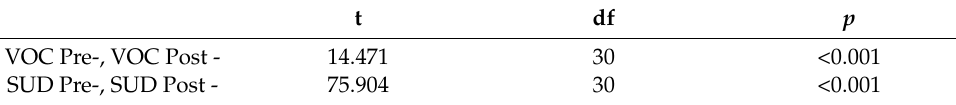
Table 6. Paired samples t -test—secondary outcome measures (pre- and post- assessment).